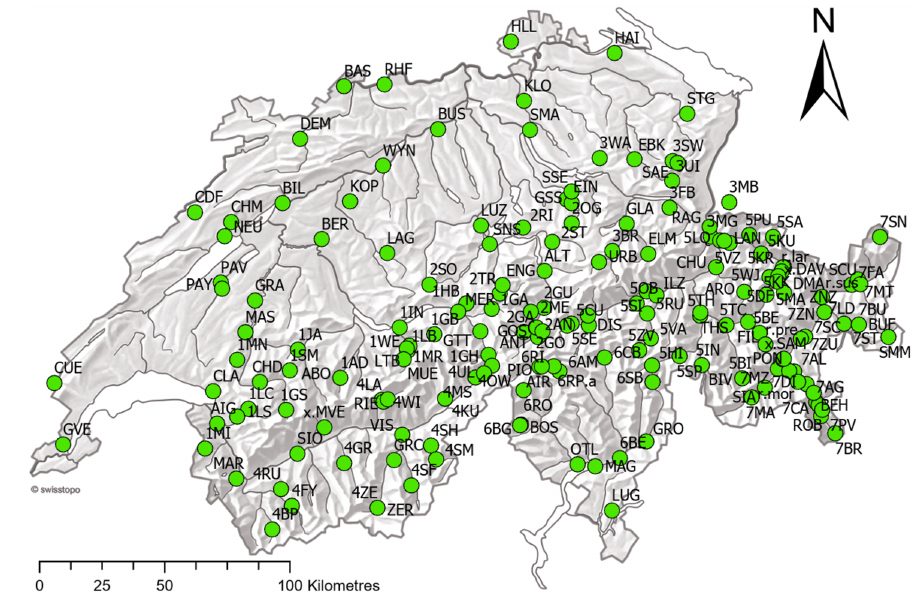
Figure 1. Map of Switzerland showing the distribution of the 184 stations used in this study. Table 1. Settings for HOMER, ACMANT, and